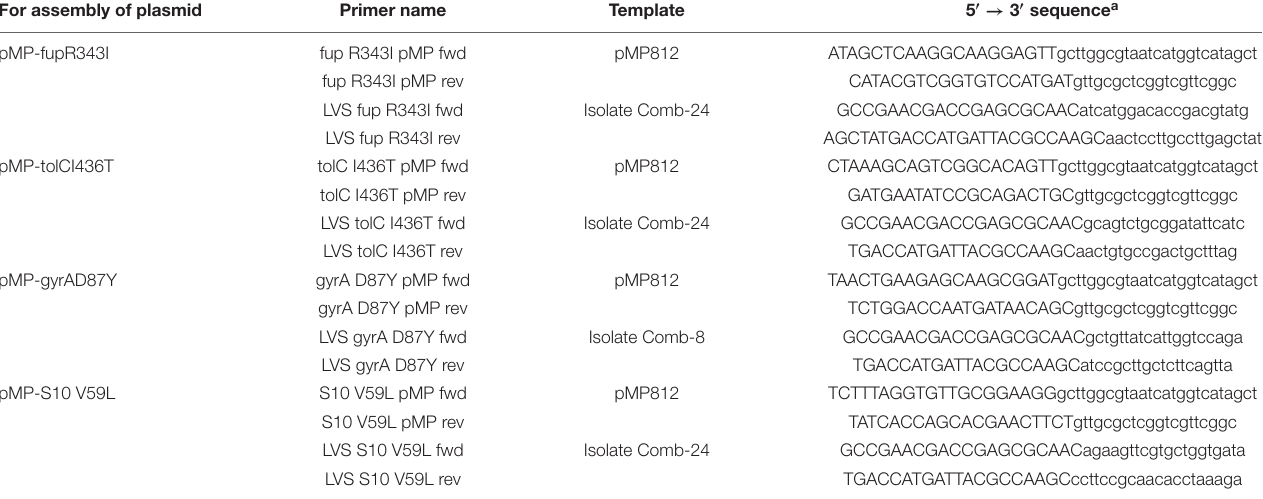
TABLE 2 | Gibson assembly